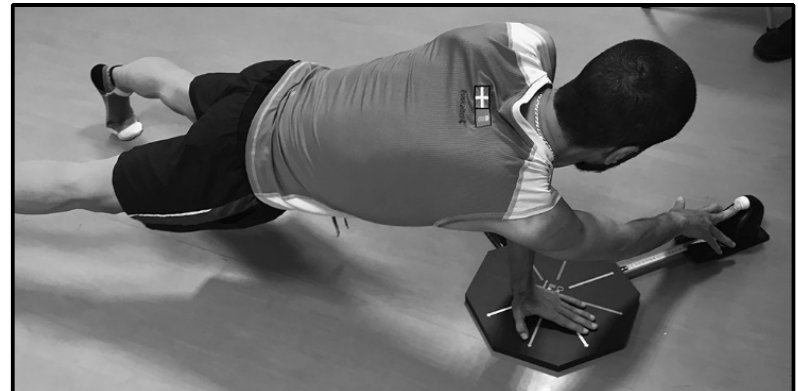
Figure 4. OB in the superolateral direction.